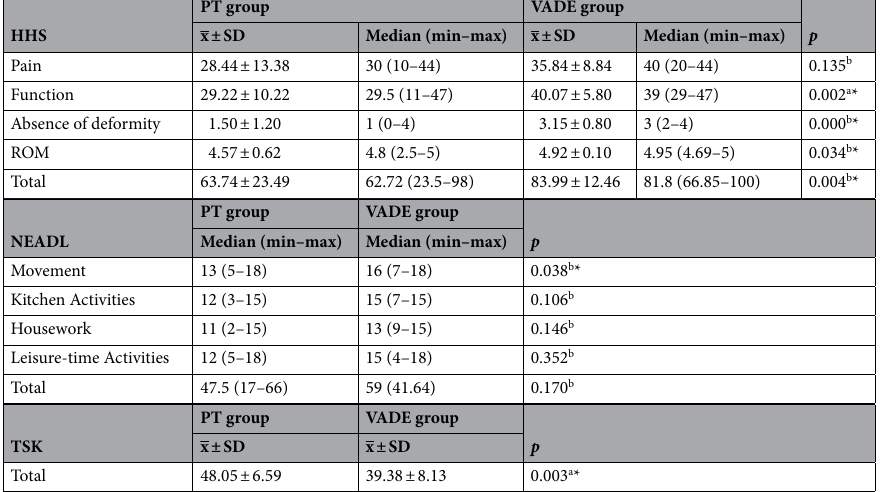
Table 3. Comparison of hip function, activities of daily living and kinesiophobia. PT physiotherapy, VADE video-assisted discharge education, ROM range of motion, HHS Harris Hip Score, NEADL Nottingham Extended Activities of Daily Living Scale, TSK Tampa Scale of Kinesiophobia, min minimum, max maximum, * p < 0.05 statistically significant difference, x mean, SD standard deviation, p a independent sample T-test, p b Mann Whitney-U